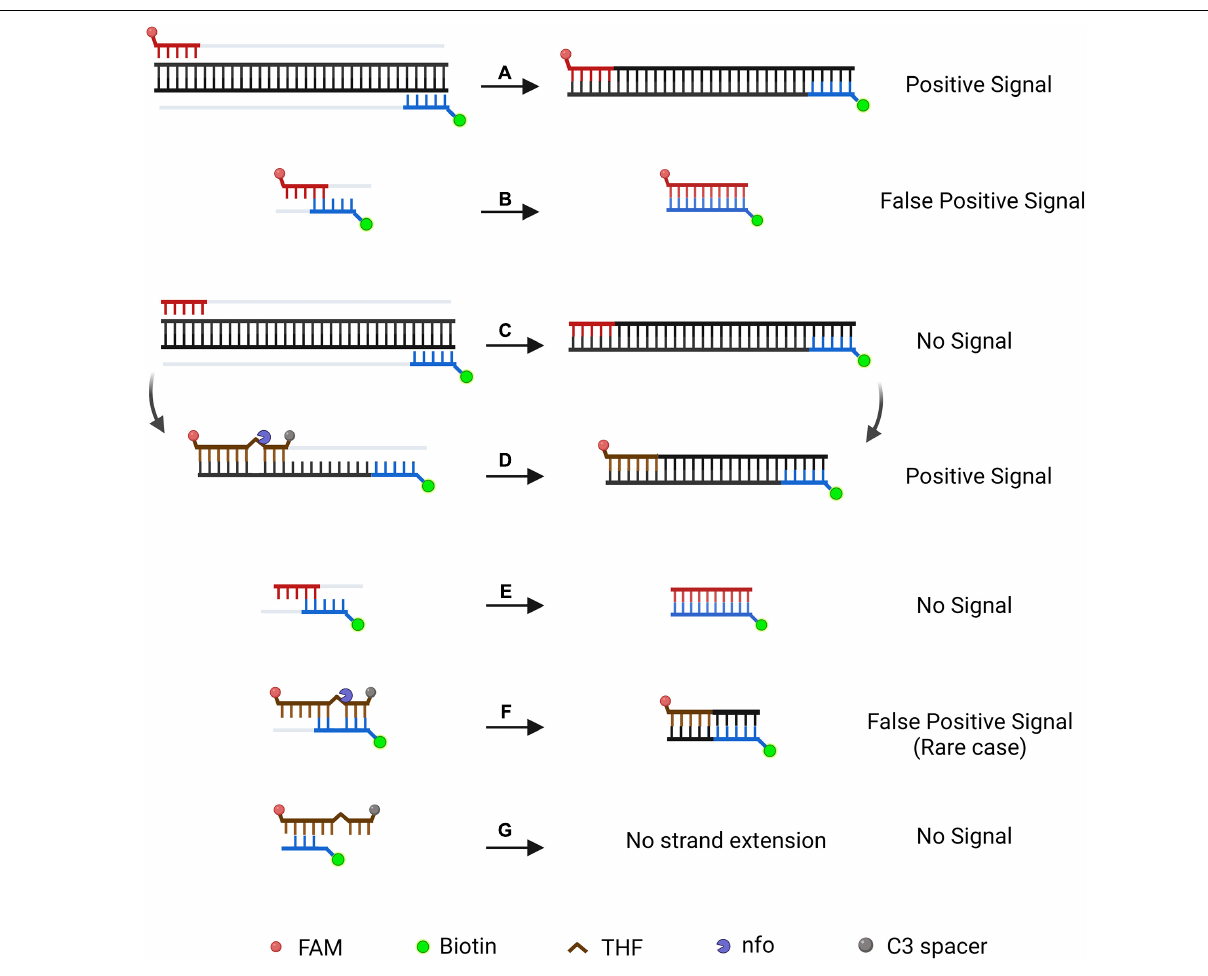
Frontiers in Plant Science |